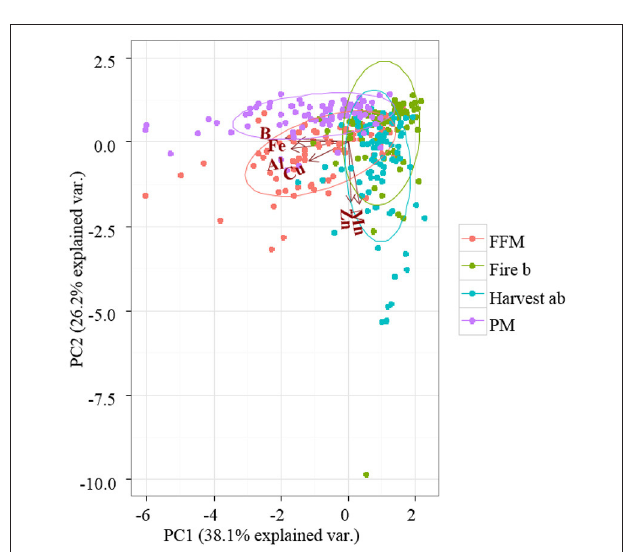
FIGURE 4 | Principal component analysis (PCA) of measured bioavailable micronutrients. Nutrient bioavailability was measured with PRS TM probes. Peat mineral-mix (PM), forest floor mineral-mix (FFM), Harvest ab by timber harvesting disturbed a/b ecosite, Fire b a by forest fire disturbed type b ecosite.